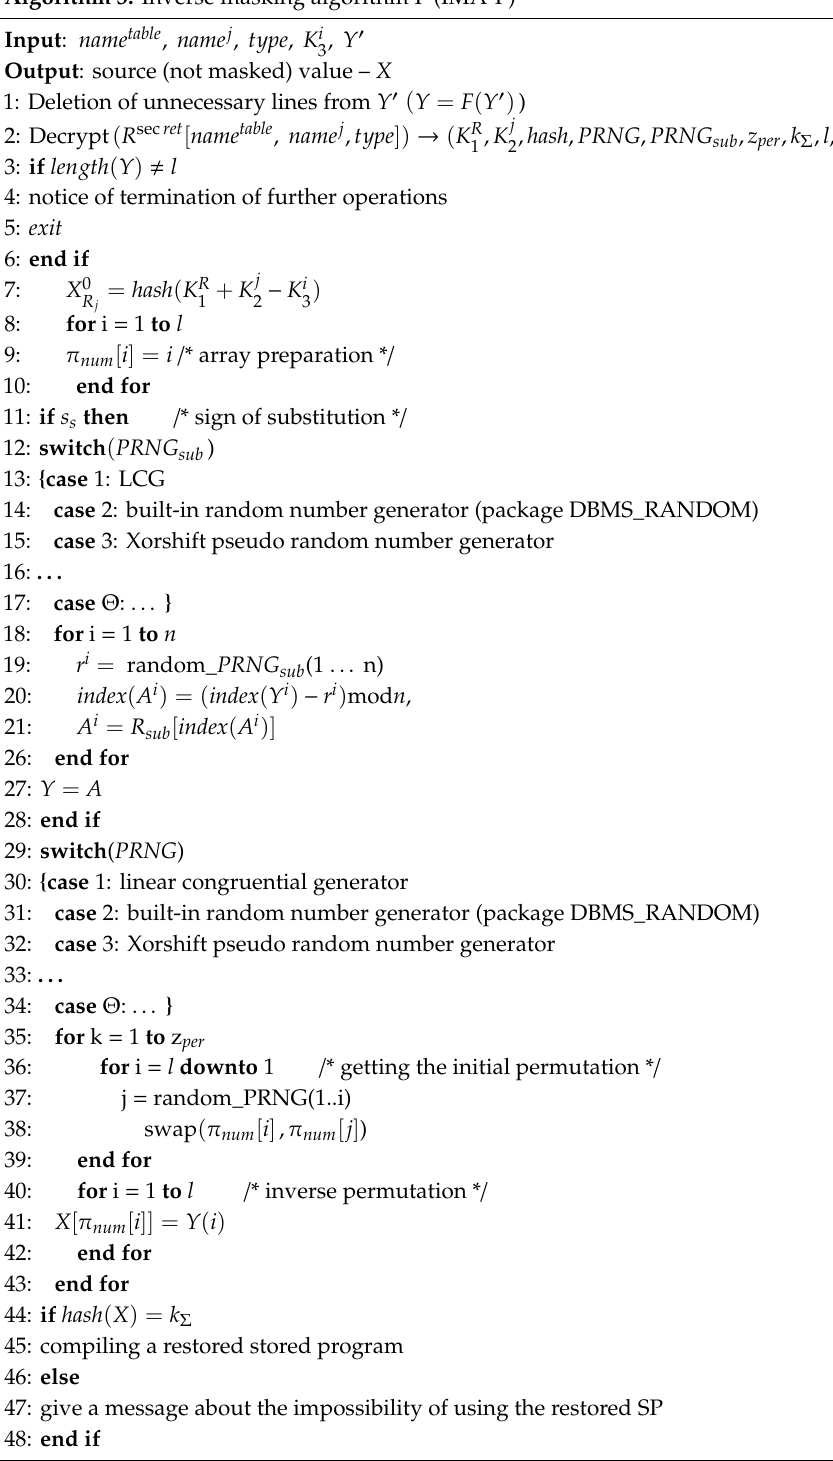
Algorithm 3. Inverse masking algorithm P